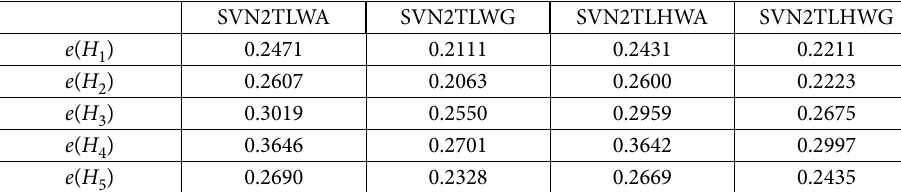
Table 8. Score results of alternatives H f